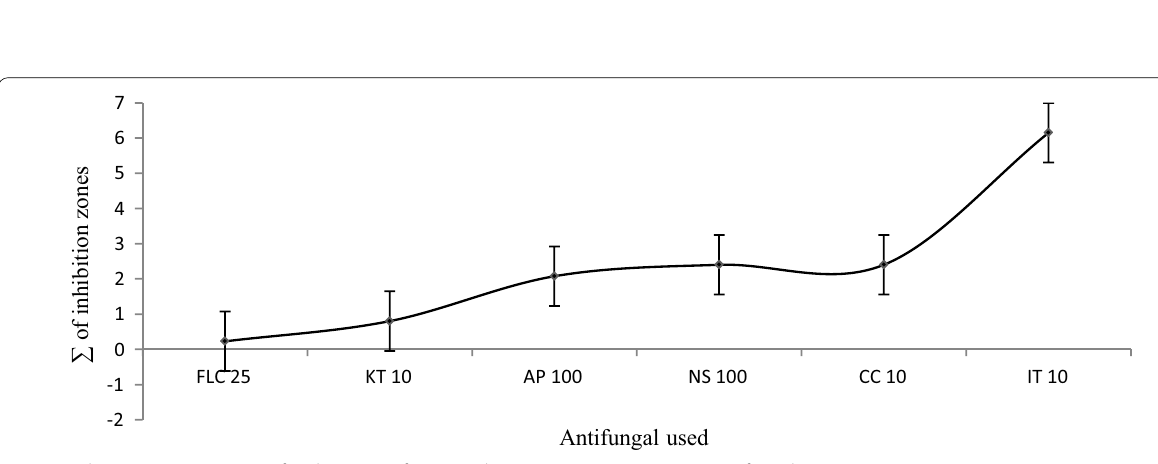
Fig. 5 Tolerance pattern (mean of replications) of PSMC isolates against some common antifungal